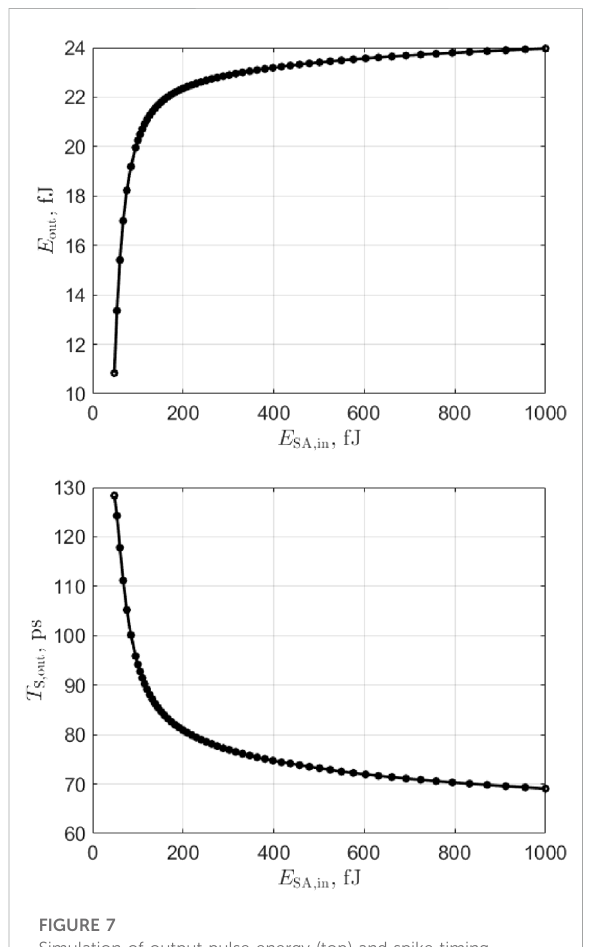
FIGURE 7 Simulation of output pulse energy (top) and spike timing (bottom) as a function of SA input pulse energy for i bias = 13 mA. A minimum input pulse energy of 48 fJ is required to trigger an output spike.